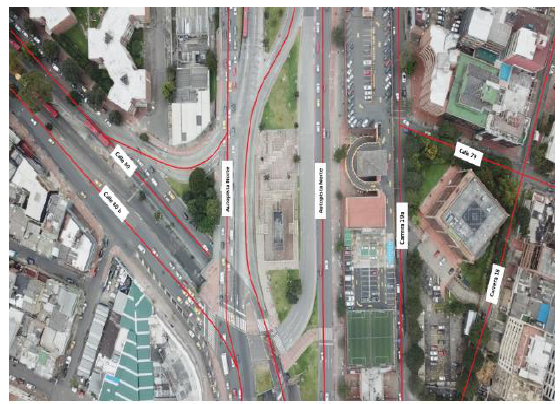
Figure 2: Location Of The Monument Of Heroes Using A Google Maps Image As A